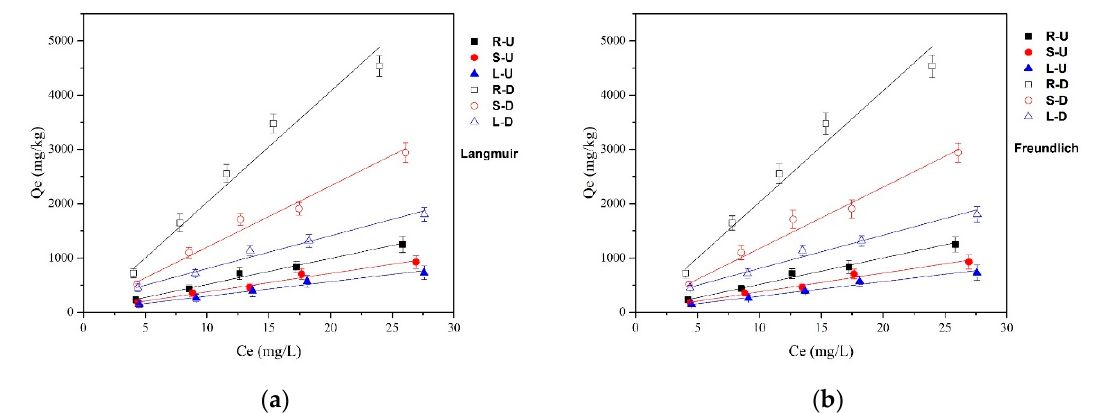
Figure 3. The isothermal models of OTC adsorption by reed residues. ( a ) Langmuir; ( b ) Freundlich. Table 2. The parameters of isotherm models.